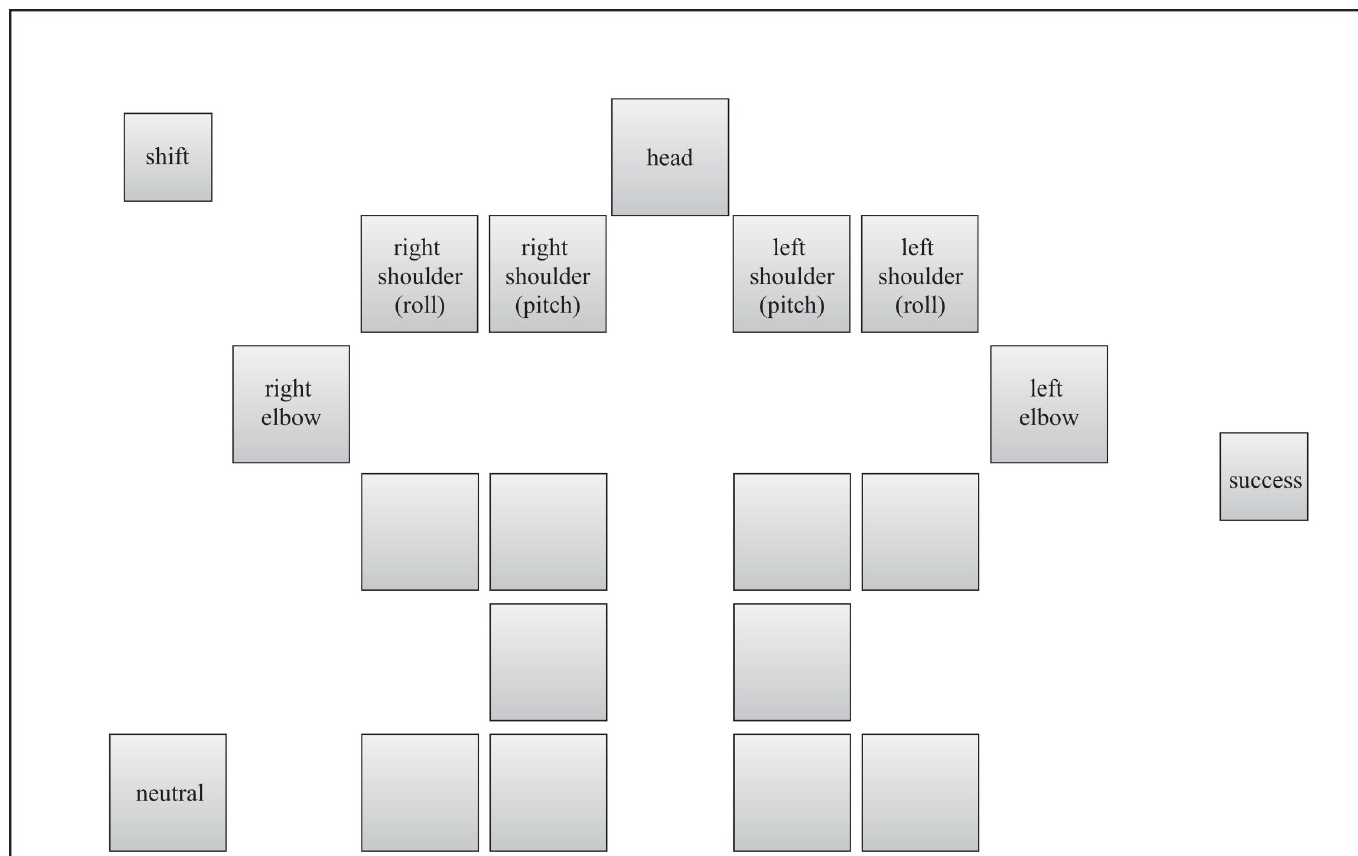
Fig 3. Command layout of the random controller displayed on the tablet PC. https://doi.org/10.1371/journal.pone.0272782.g003 provided. The relationship between the buttons, joints, and their rotational directions was also examined by the participants. After receiving instructions, the participants operated the robot.